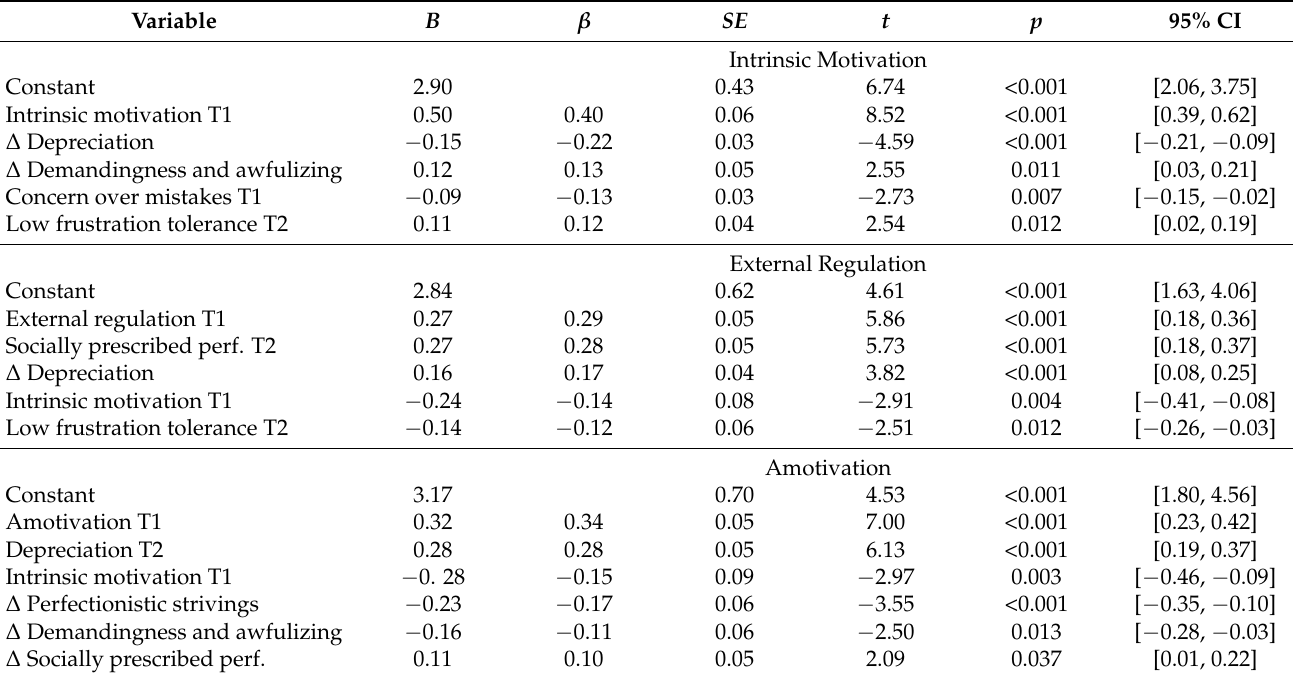
Table 3. Regression analyses of current behavioral regulation among talented